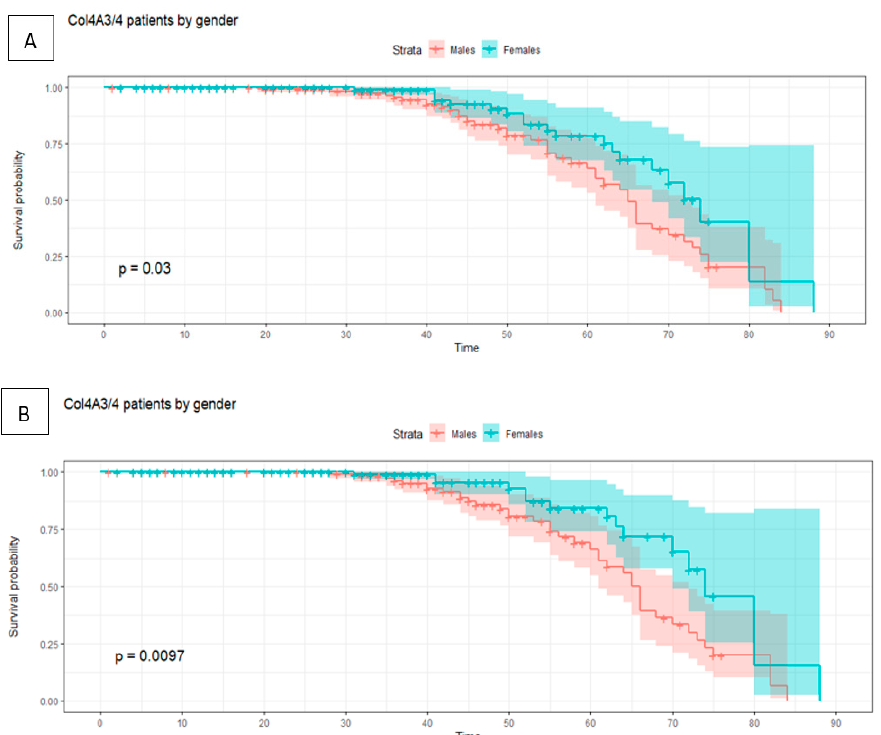
Figure 3. The cumulative probability of adverse renal events (ESKD, CKD, dialysis, renal transplant, or death due to renal failure) segregated by gene and sex. ( A ) This figure represents the cumulative probability of renal failure with sex segregation in patients with heterozygous deleterious mutations in COL4A3/4, observing borderline statistical differences between the males (in red) and females (in turquoise), with p value = 0.03. ( B ) This figure represents the cumulative probability of renal failure excluding CRD with sex segregation in patients with heterozygous deleterious mutations in COL4A3/4, observing statistical differences between the males (in red) and females (in turquoise) with a p value = 0.0097.